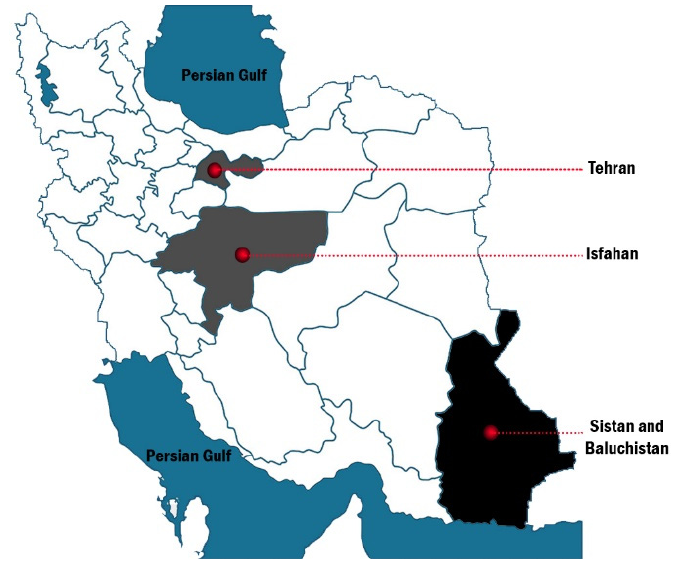
Figure 1. Location of Sistan in Iran.